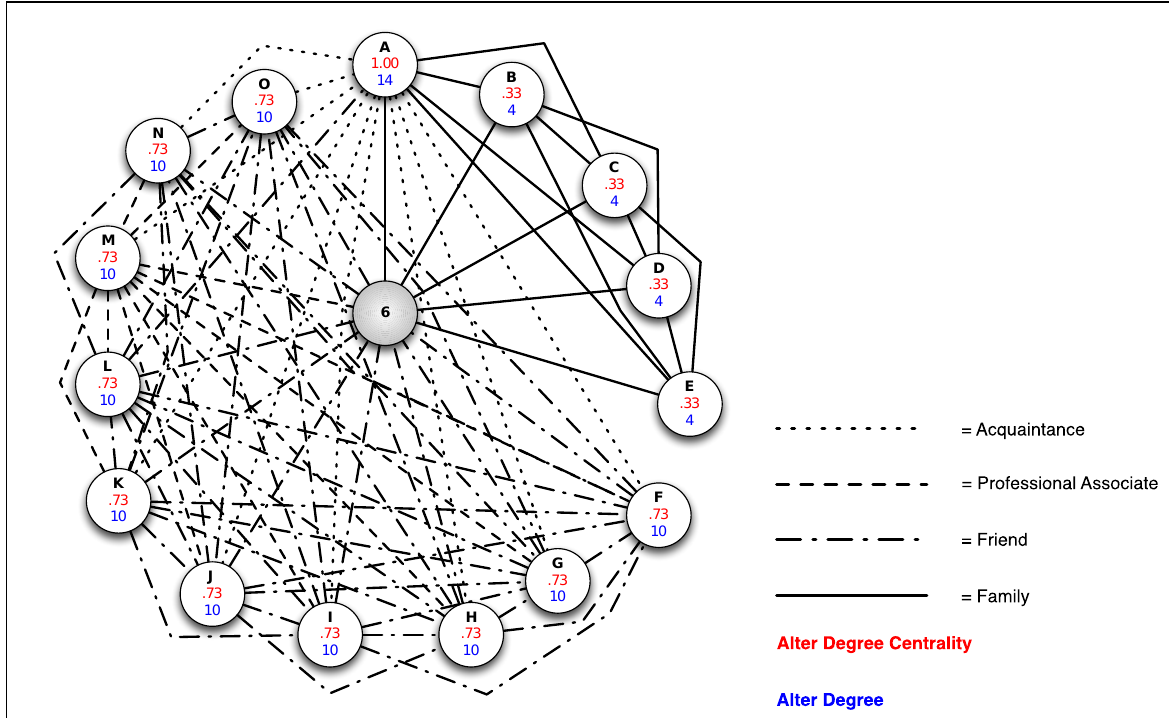
Figure 5. Farmer’s Support Network Displayed is an extensive support network structure with a large number of ties relative to other farmer support